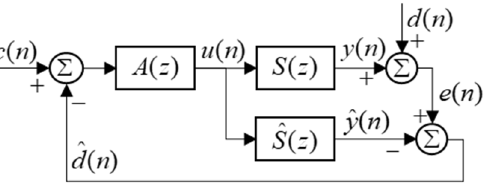
Figure 5. Block diagram of a feedback target tracking control algorithm with the IMC structure.